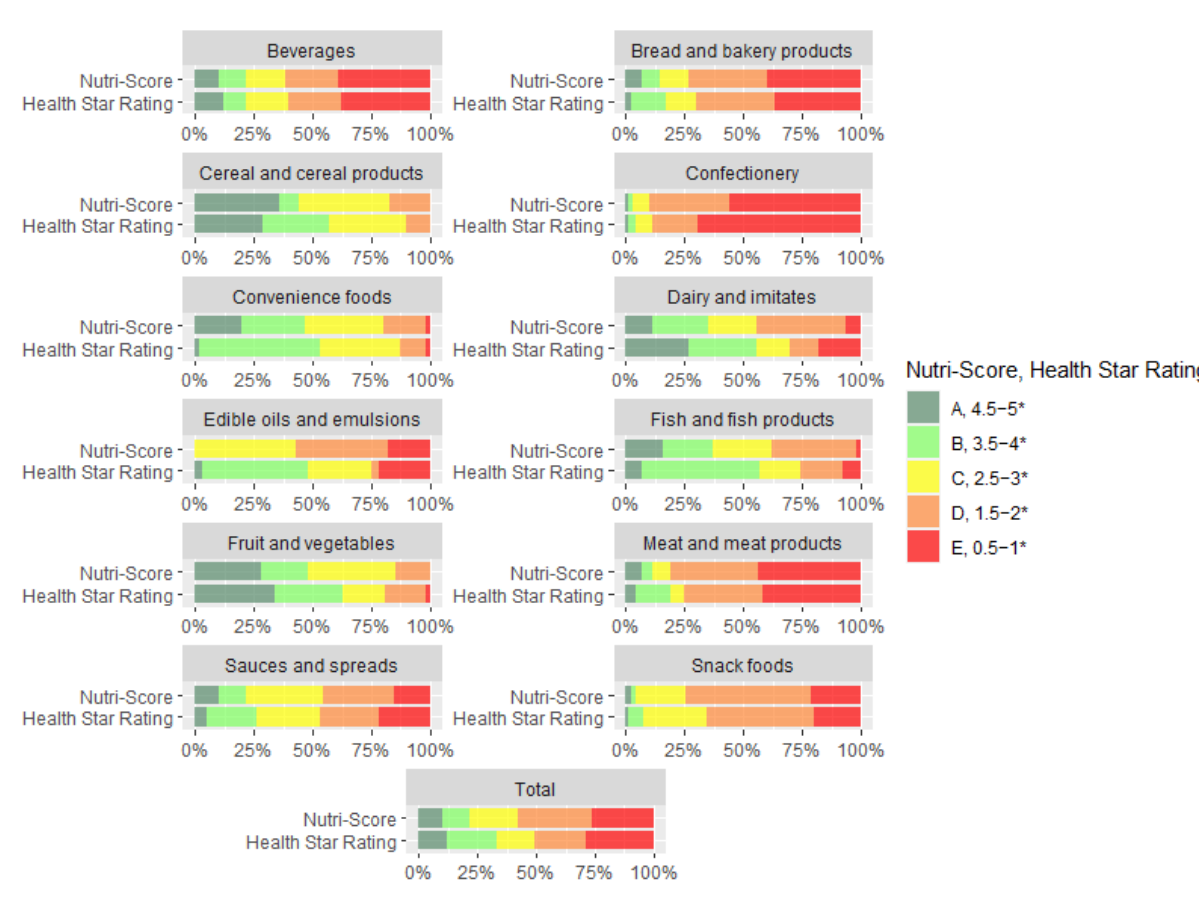
Figure 1. Overall distribution of profiling scores according to Nutri-Score (FSAm-NPS (Food Stand- ard Agency- Nutrient Profiling System)) and Health Star Rating algorithm in conjunction with their final grade. Colours represent different Nutri-Score and Health Star Rating grades across 2020 Slo- venian food supply (n = 17,226). * refers to stars of Health Star Rating grades.